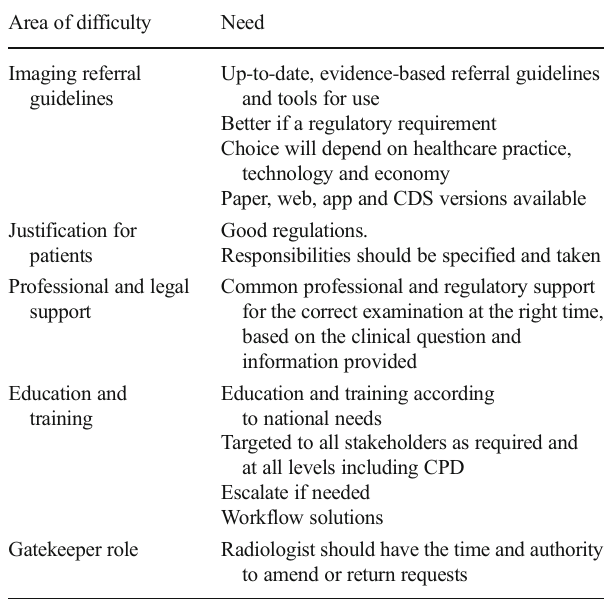
Areas of difficulty and solutions for providing more appropriate imaging for patients Area of difficulty